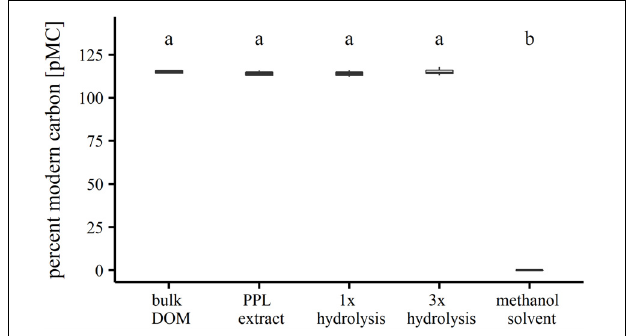
FIGURE 1 | Radiocarbon analysis of SPE-DOM before and after extraction and after hydrolysis of potential residual ester-bound methanol.